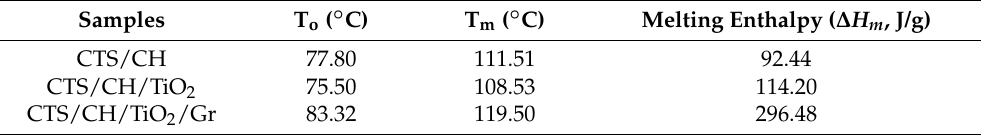
Table 2. Thermal characteristics of CTS/CH, CTS/CH/TiO 2 , and CTS/CH/TiO 2 /Gr (TiO 2 : Gr = 6:4) composite films with ultrasonic power of 160